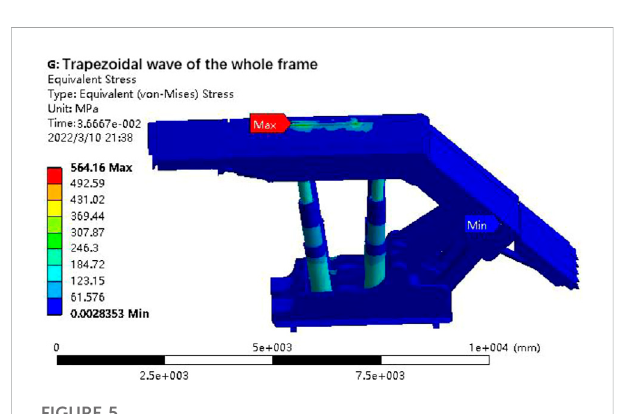
FIGURE 5 Stress nephogram after